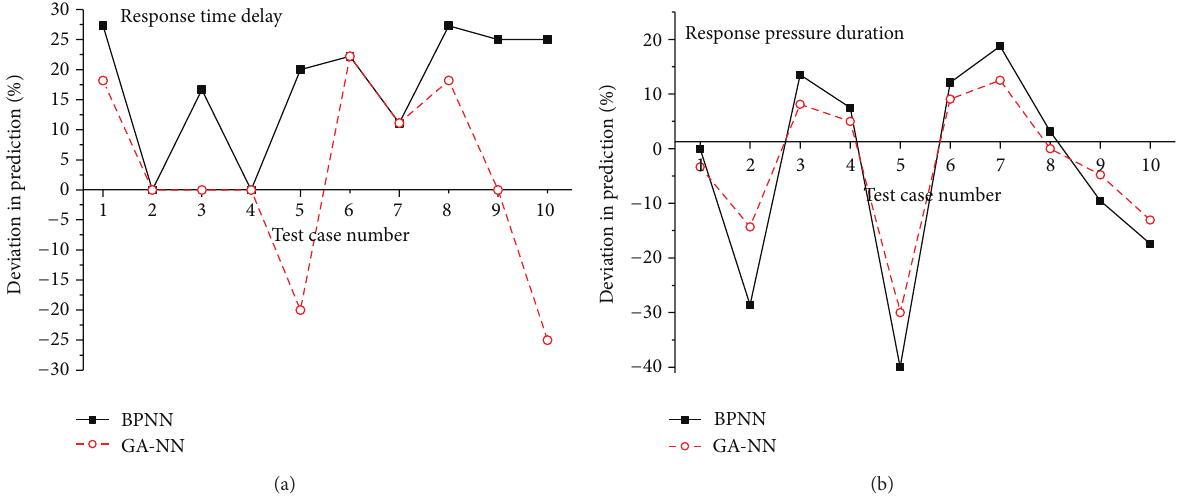
Figure 6: Comparison of NN based approaches in predicting the responses. (a) Time delay and (b) pressure duration.